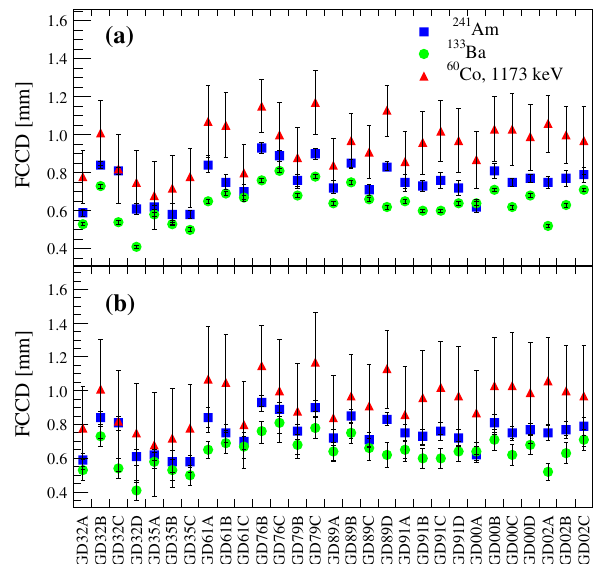
Fig. 10 FCCDvaluesof29 Gerda PhaseIIBEGedetectorsexcluding GD02D. The FCCD values in plot ( a ) contain only the uncorrelated uncertainties, while in plot ( b ) they contain the combined correlated and uncorrelated